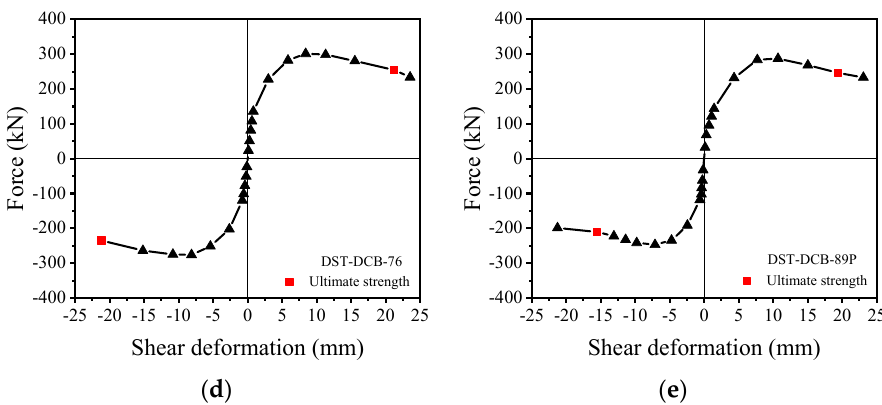
Figure 11. Analysis of shear deformation: ( a ) DCB; ( b ) LRS-DCB; ( c ) DST-DCB-89; ( d ) DST-DCB-76; ( e ) DST-DCB-89P.